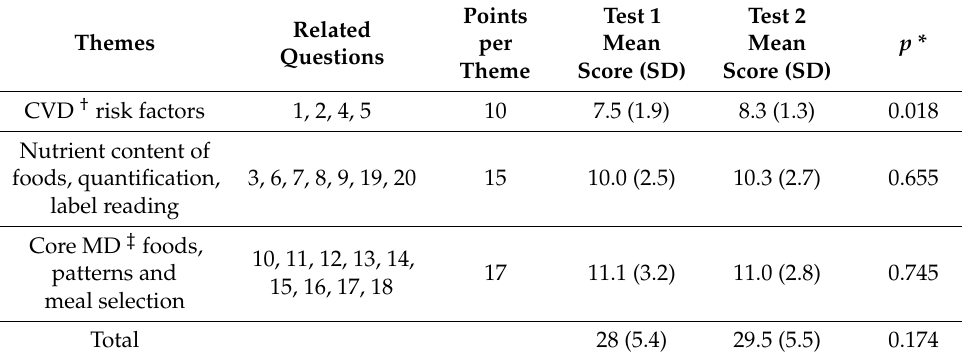
Table 2. Scoring of Med-NQK based on